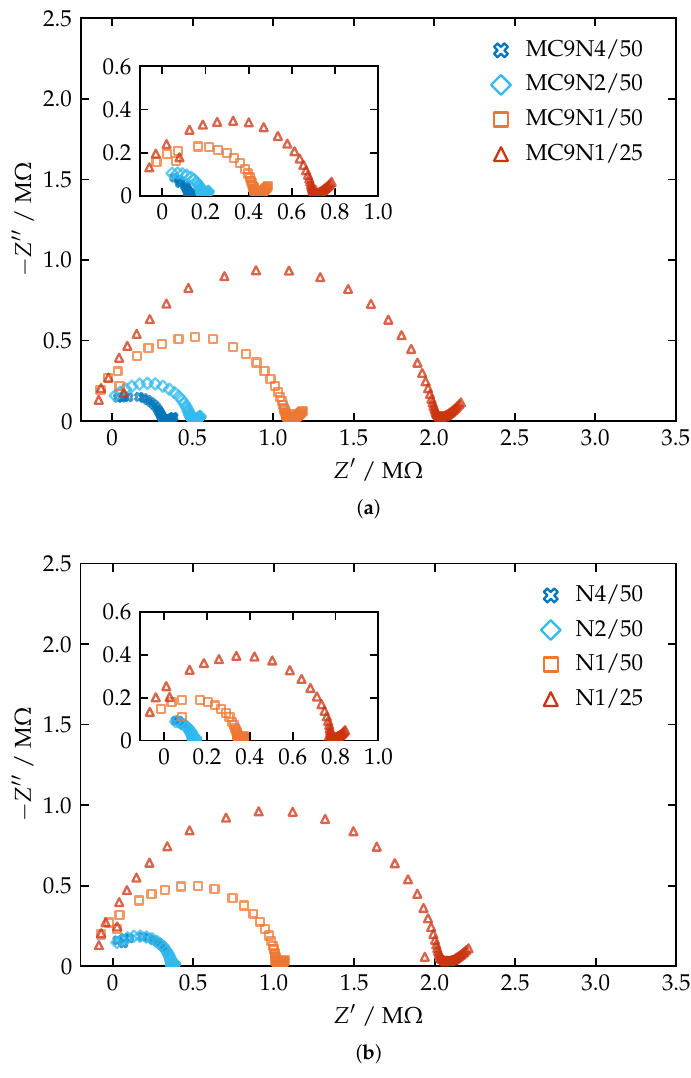
Figure A2. Impedance spectra of ( a ) sensors incorporating MC9 and ( b ) control sensors. The membranes were all plasticized with o -NPOE. PVC-shelled sensors are shown in the main plots and PCTFE-shelled sensors in the insets. Measurements were performed in 10 − 1 M sodium acetate with the parameters f = 100mHz–100kHz, E dc = 0V vs OCP, and ∆ E ac = 100mV ( RMS ) . See Table 1 for membrane compositions.